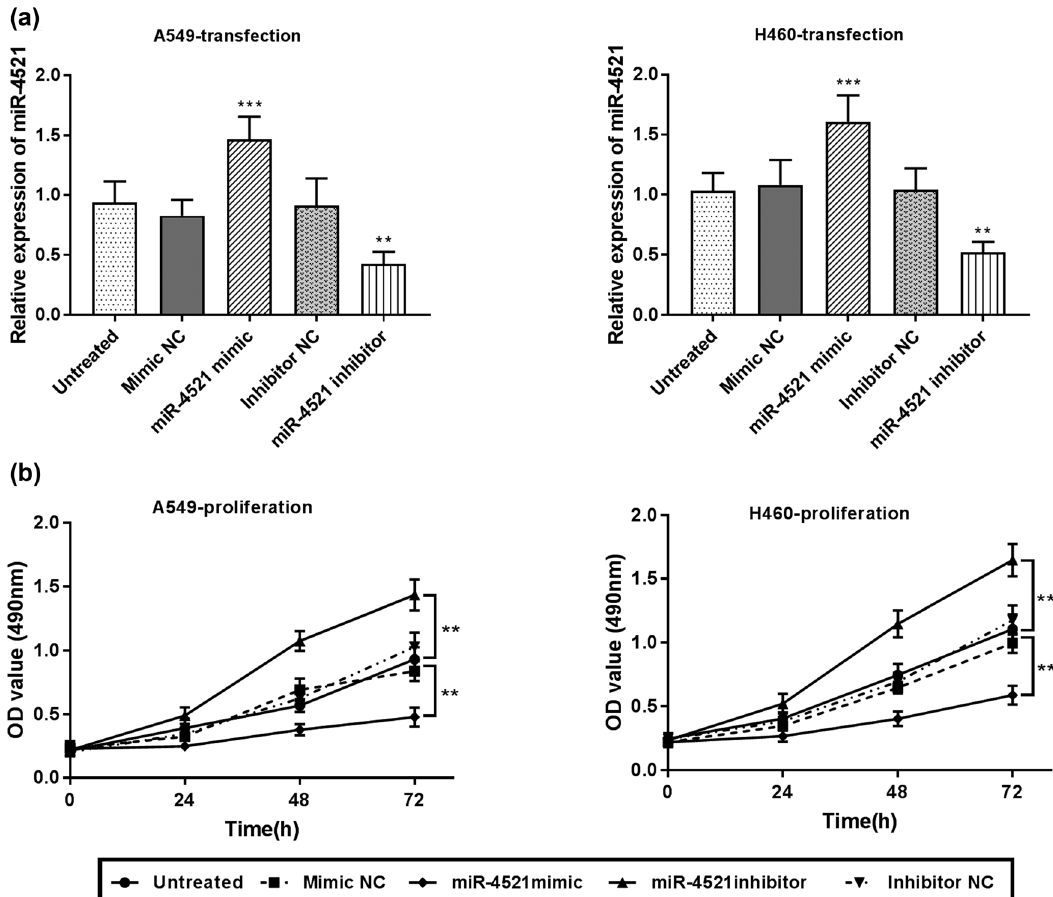
Figure 3: The e ff ect of the miR - 4521 expression on cell proliferation. ( a ) miR - 4521 mimic promoted the expression of miR - 4521, while miR - 4521 inhibitor suppressed its expression ( ** P < 0.01, *** P < 0.001 ) . ( b ) miR - 4521 mimics can suppress A549 and H460 cell proliferation, while miR - 4521 inhibitors can promote cell proliferation ( ** P < 0.01 )